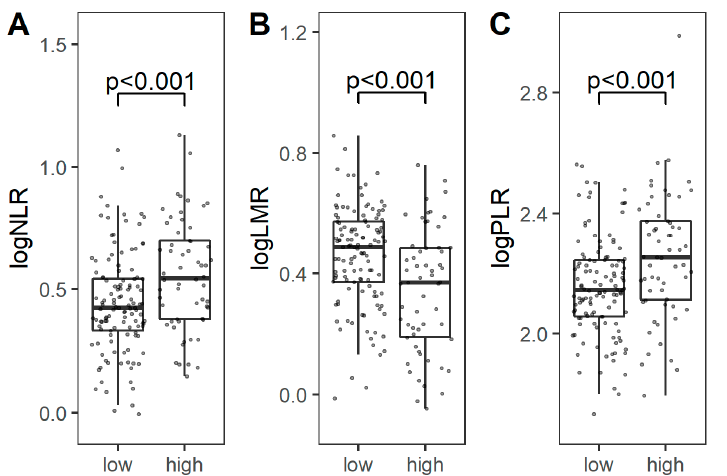
Figure 4. Comparison of logarithmic NLR ( A ), LMR ( B ), and PLR ( C ) between low-stage (I) and high-stage (II/III) tumors. Abbreviations: NLR: neutrophil-to-lymphocyte ratio; LMR: lymphocyte- to-monocyte ratio; PLR: platelet-to-lymphocyte ration.